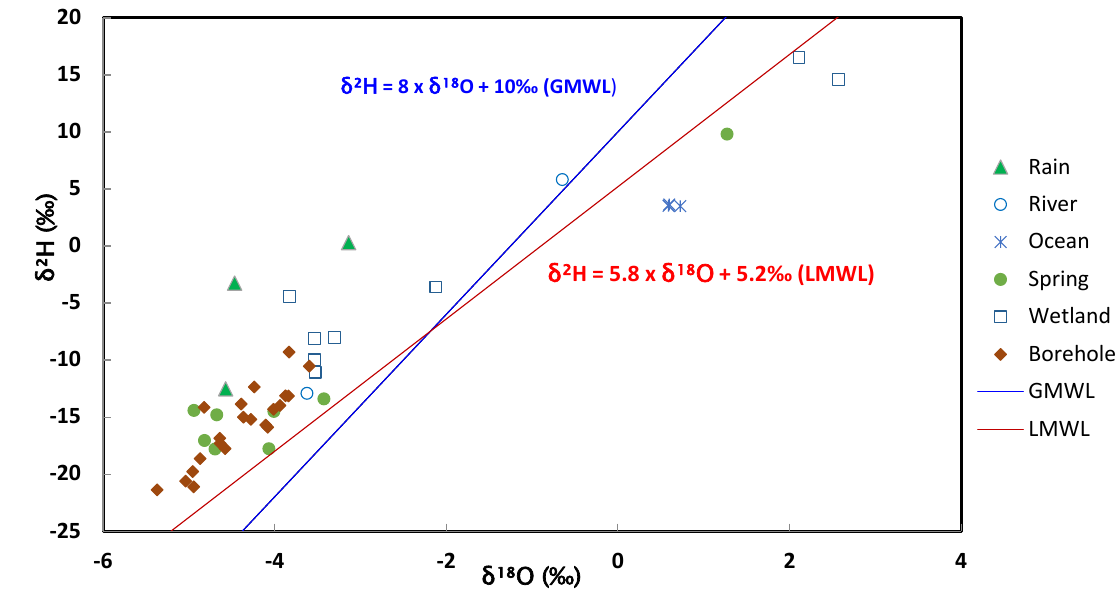
Figure 9. Environmental stable isotope ( δ 18 O and δ 2 H) plot for surface water and groundwater samples. Table 4. Stable isotope values and d−excess in the Thyspunt area.